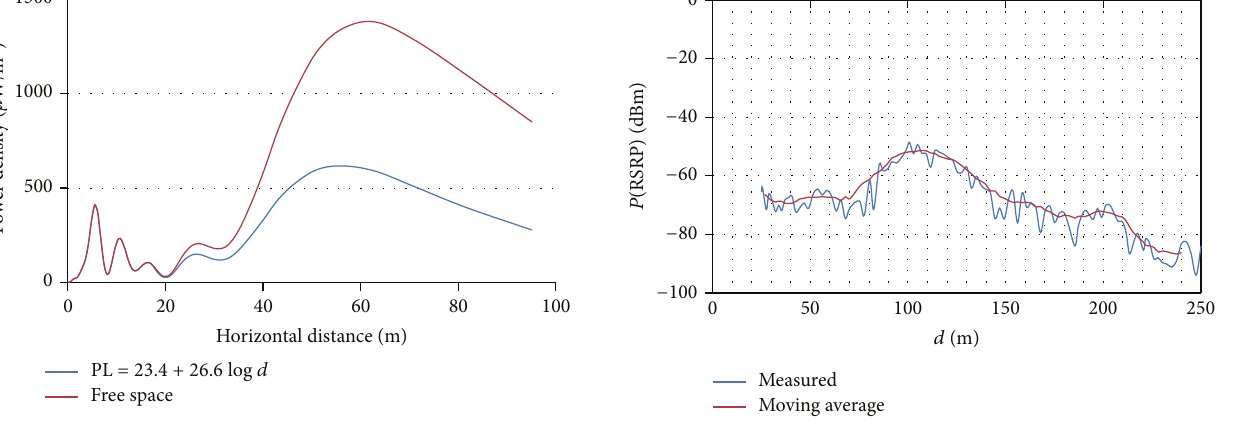
Figure 9: RSRP of a 20 MHz LTE signal for antenna tilt of 6 ∘